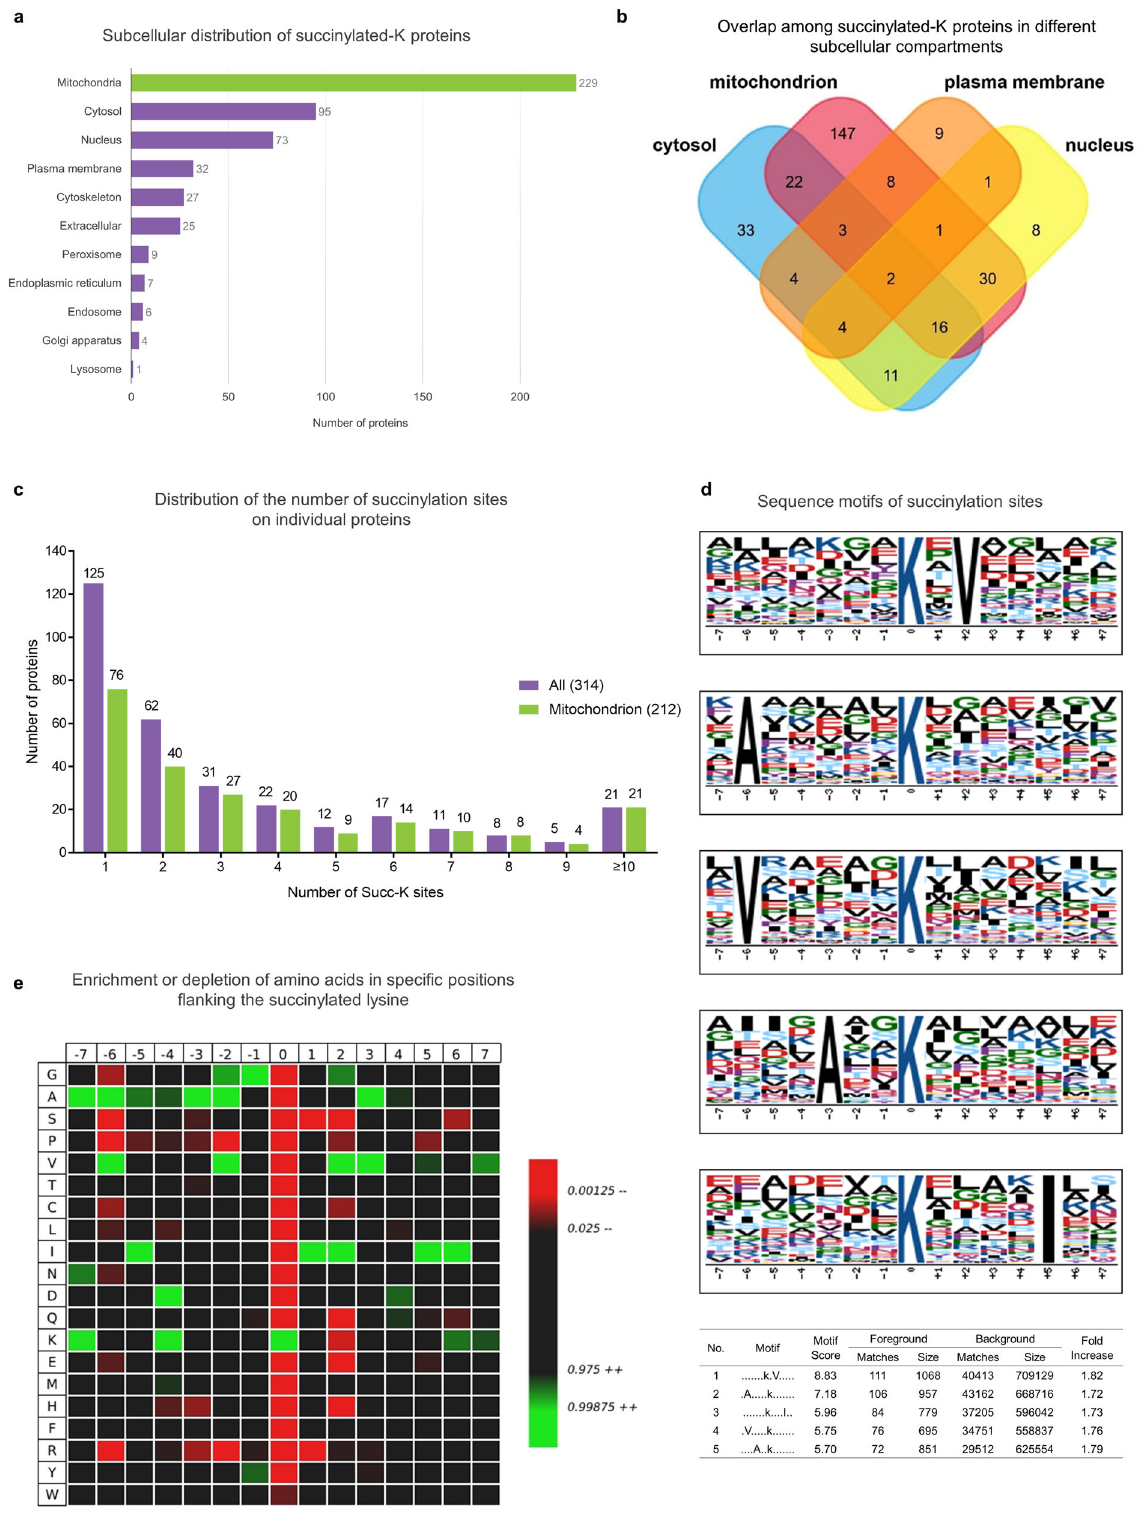
(two-tailed Student ’ s t -test, p < 0.05 and |log 2 FC | >0.25). Eight proteins decreased in brains from AD patients while 73 protein levels were increased (Supplementary Fig. 2a). In a recent large- scale proteomic scan, the protein abundance of PDHA, PDHB, and DLD were all decreased in AD, which is consistent with our fi nding, representing a decreased abundance of proteins in impaired mitochondrial states 17 . Thus, changes in protein levels